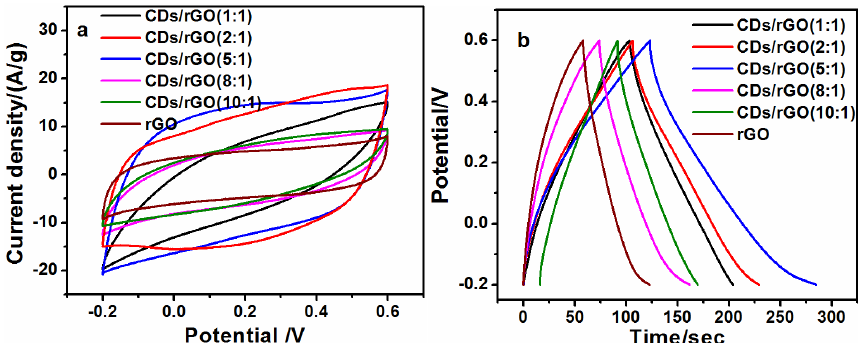
Figure 5. ( a ) CV curves of CDs/rGO (1:1), CDs/rGO (2:1), CDs/rGO (5:1), CDs/rGO (8:1), CDs/rGO (10:1), and rGO at a scan rate of 0.2 V/s; ( b ) GCD curves of CDs/rGO (1:1), CDs/rGO (2:1), CDs/rGO (5:1), CDs/rGO (8:1), CDs/rGO (10:1), and rGO at a current density of 0.5 A/g.